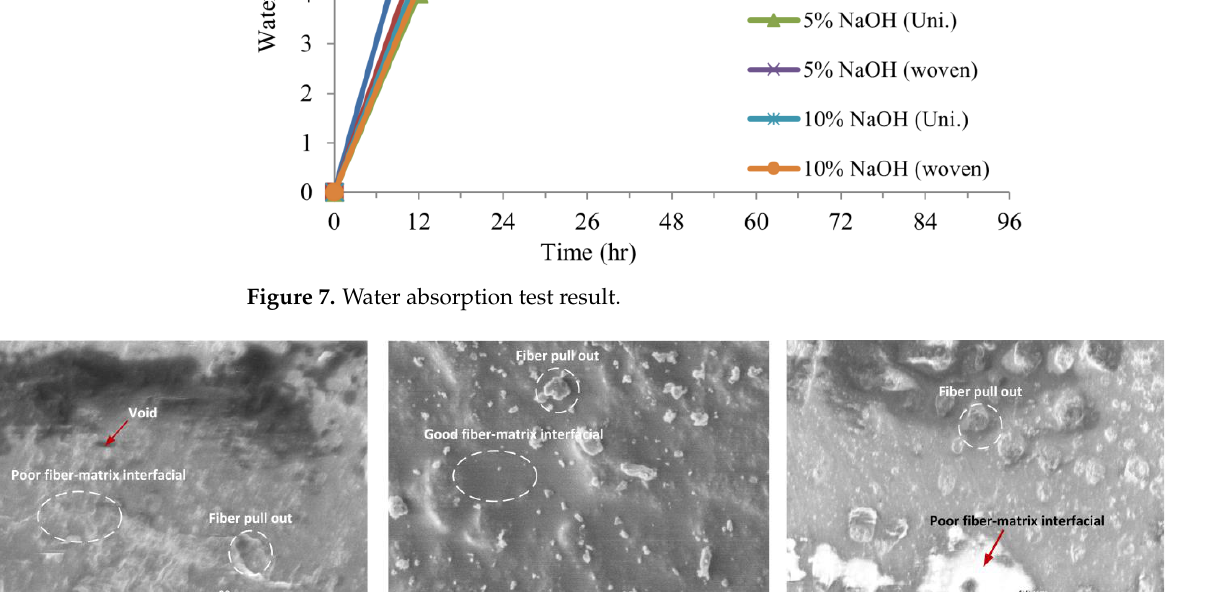
Figure 7. Water absorption test result.